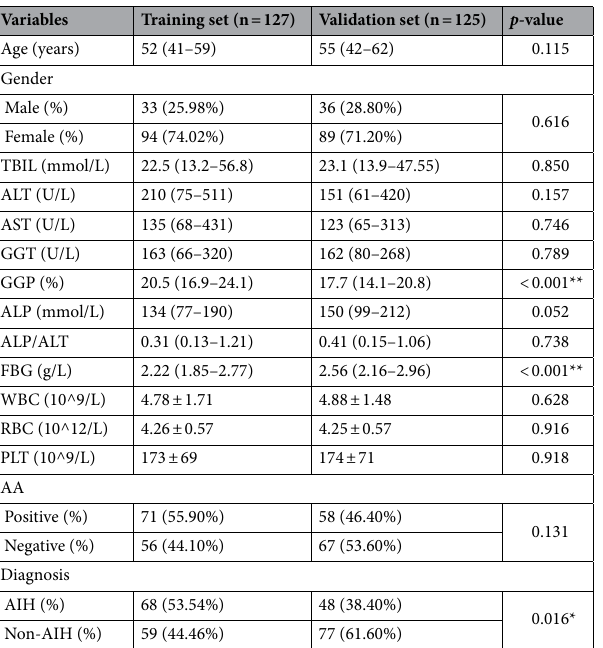
Table 1. Comparison of factor characteristics between training set and validation set (n = 252). Data are shown as the means ± SD, median (interquartile range) or frequencies (%). TBIL total bilirubin, ALT alanine